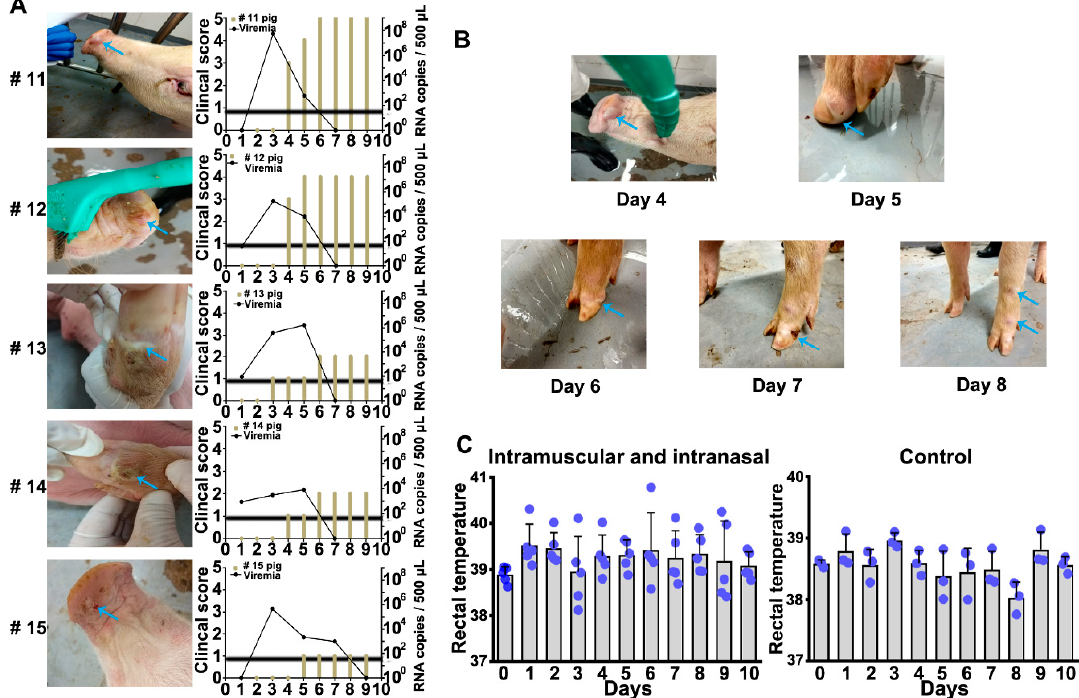
Figure 1. Clinical symptoms and rectal temperature after Senecavirus A (SVA) infection in pigs. ( A ) Pigs infected intramuscularly (3 mL, 7 × 10 7.8 PFU/mL) and intranasally (1.5 mL into each nostril, 7 × 10 7.8 PFU/mL). Clinical symptoms of pigs were recorded during the test and scored in order. Pigs 11,12, and 15 had blisters in the nose; 13 and 14 had blisters in the hoof. Serum was collected and the virus content was detected using qRT-PCR technology; ( B ) clinical symptoms after SVA CH-2017-HB strain infection. Pigs developed blisters in the nose at four days and white blisters in the hoof at five and six days. Blisters ulcerated at seven days and the joints were red and swollen. The rupture of the hoof gradually returned at eight days; ( C ) rectal temperature 1–10 days after SVA infection in pigs (Intramuscularly (3 mL, 7 × 10 7.8 PFU/mL ) and intranasal (1.5 mL into each nostril, 7 × 10 7.8 PFU/mL) group ( n = 5)). All clinical changes indicated by blue arrows. Black line represents the cutoff value of the qRT-PCR technology detection. Table 1 . SVA CH-HB-2017-strain-infected minimum dose exploration.